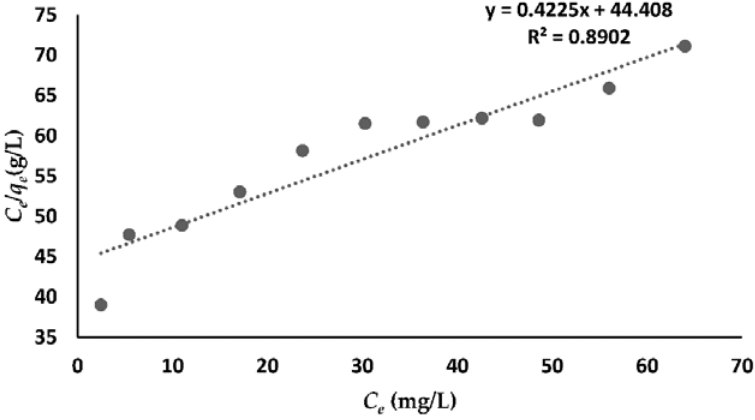
Figure 10. Langmuir isotherm plot of HDTMA-VMT 0.2M . Table 1. Adsorption isotherm constants.